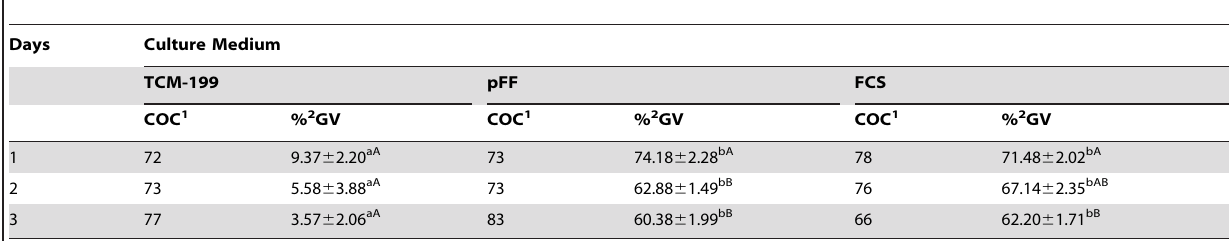
Table 2. The GVBD inhibition after preservation for different times in different media at 27.5 u C.